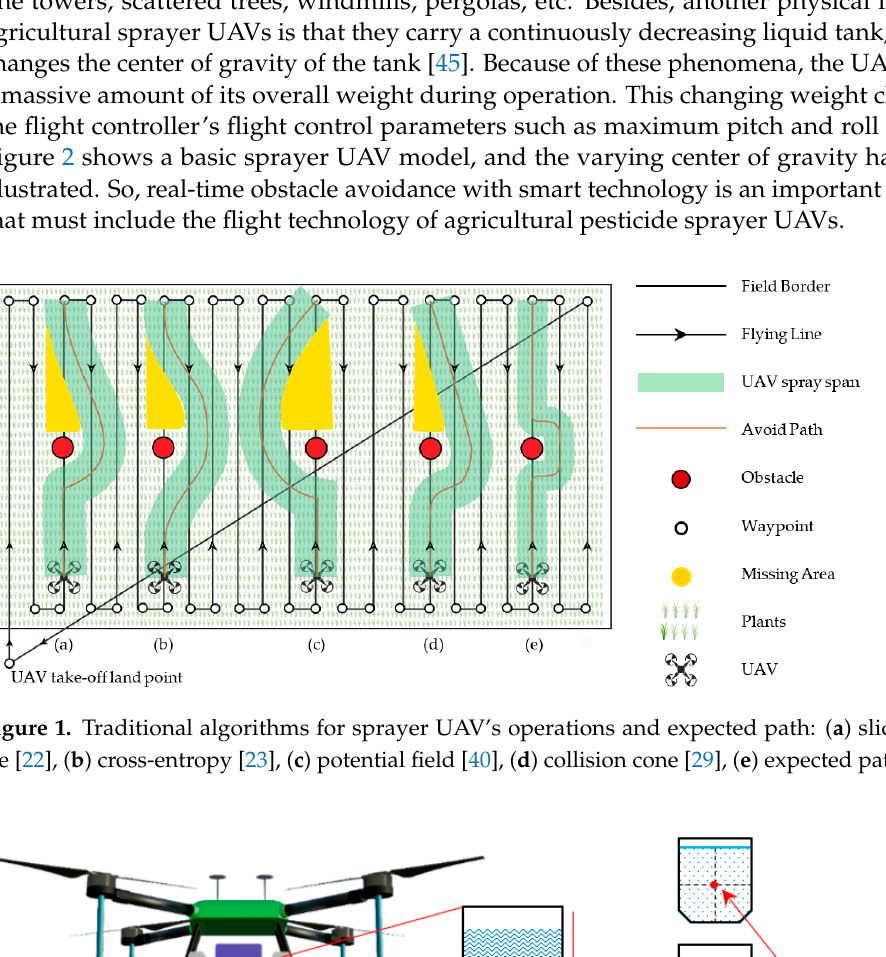
Figure 1. Traditional algorithms for sprayer UAV’s operations and expected path: ( a ) sliding circle [22], ( b ) cross-entropy [23], ( c ) potential field [40], ( d ) collision cone [29], ( e ) expected path.